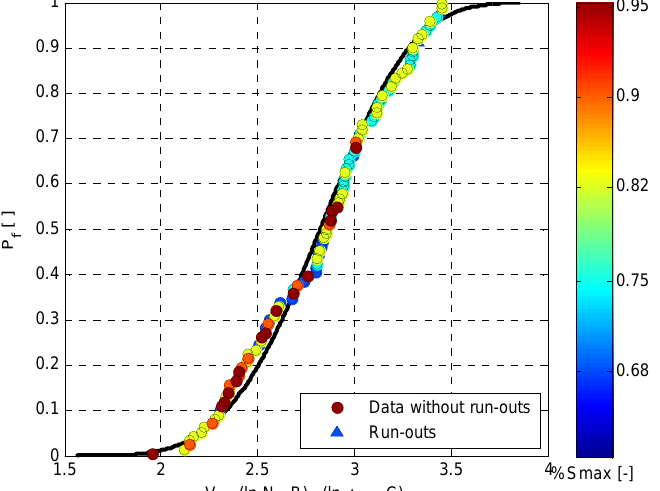
Figure 6: Experimental Weibull cumulative distribution functions for the normalized variable V obtained from the fatigue results under constant stress range tests of Holmen [4] using the probabilistic fatigue model of Castillo and Fernández-Canteli